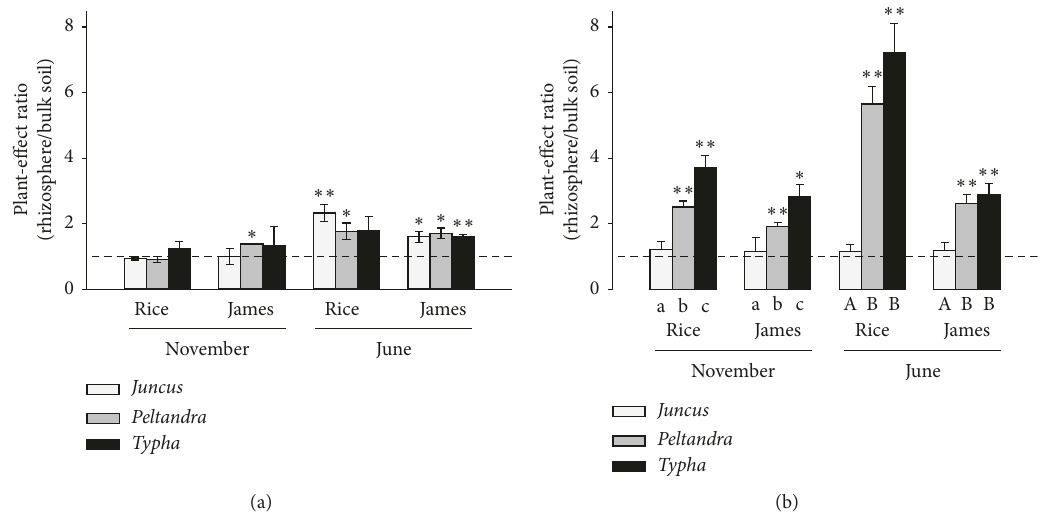
Figure 2: Plant-effect ratio for (a) bacteria and (b) denitrifier abundance associated with the rhizosphere of three plant species ( Juncus effuses , Peltandra virginica , and Typha latifolia ). Values are plotted as means and standard errors. A plant-effect ratio of “1” (dashed horizontal line) indicates that abundance in the rhizosphere samples was the same as abundance in the reference (unvegetated) soil. Bars with ∗ (for 0.01 ≤ p < 0 . 05) and ∗∗ (for p < 0 . 01) above them indicate the period when rhizosphere samples had significantly greater abundance than reference soils as determined via t -test. For bacteria (a), two-factor ANOVA of the effect ratios found no significant plant or site effects for either sampling date. For denitrifiers (b), main effects of site and plant type were significant for both sampling dates. Results of Tukey’s HSD post hoc tests comparing plant types are presented using letters beneath each bar (lowercase for November and uppercase for